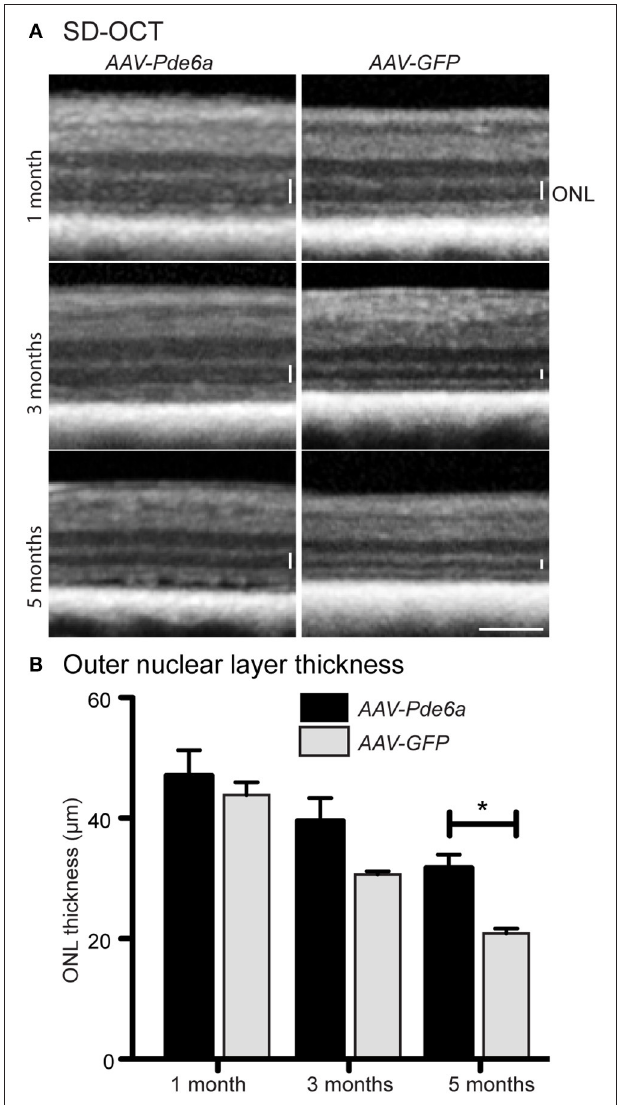
FIGURE 4 | Spectral domain optical coherence tomography. SD-OCT was performed on three animals injected with AAV-Pde6a at 41–42 days of age, contralateral eyes were injected with AAV-GFP . Animals were imaged at 1, 3, and 5 months post-treatment (A) . The outer nuclear layer in AAV-Pde6a treated eyes was thicker compared with contralateral AAV-GFP treated eyes, and this difference was significant at 5 months post-injection (B) . * p < 0.05, two-way repeated measures ANOVA, scale bar represents 200 µ